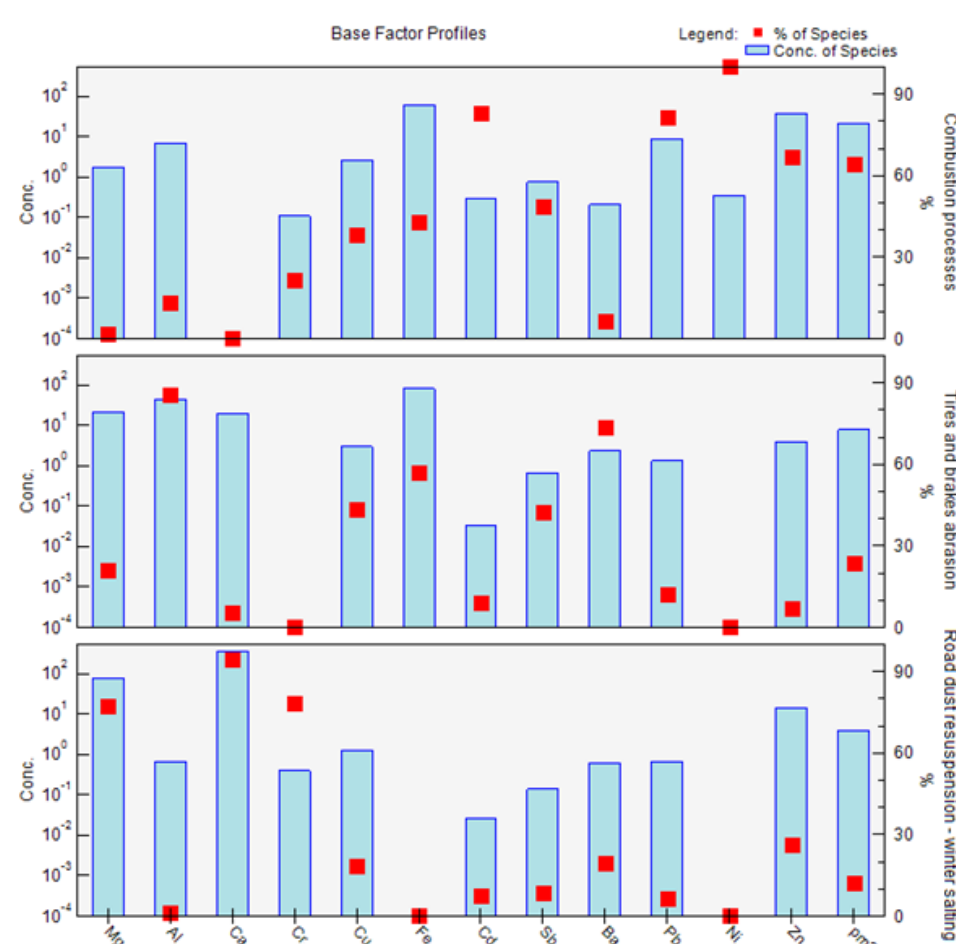
Figure 10. Factor profiles: division of elements into individual factors, and their characterization, from measurements of PM 2.5 taken in the city of Žilina.